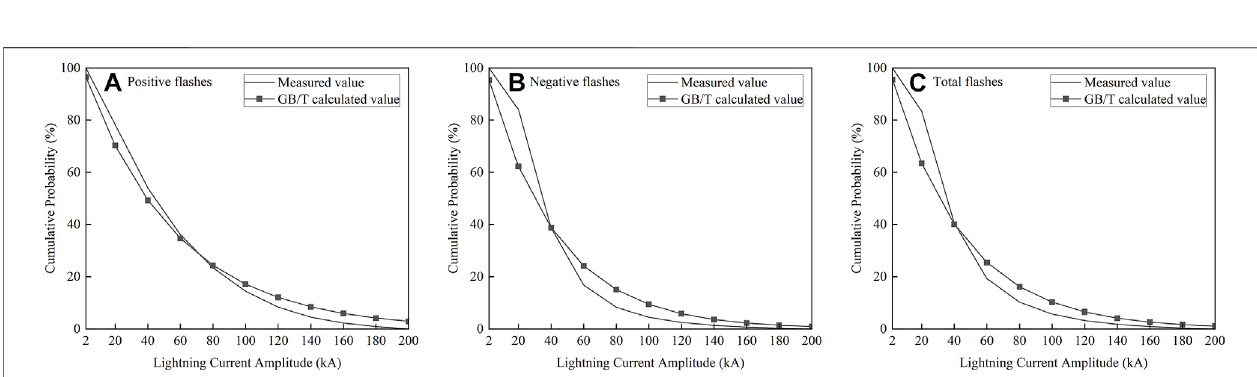
FIGURE 5 | Fitting curves based on measured values and calculated values by GB/T 50064-2014 (A) Positive fl ashes, (B) Negative fl ashes, and (C) Total fl ashes.